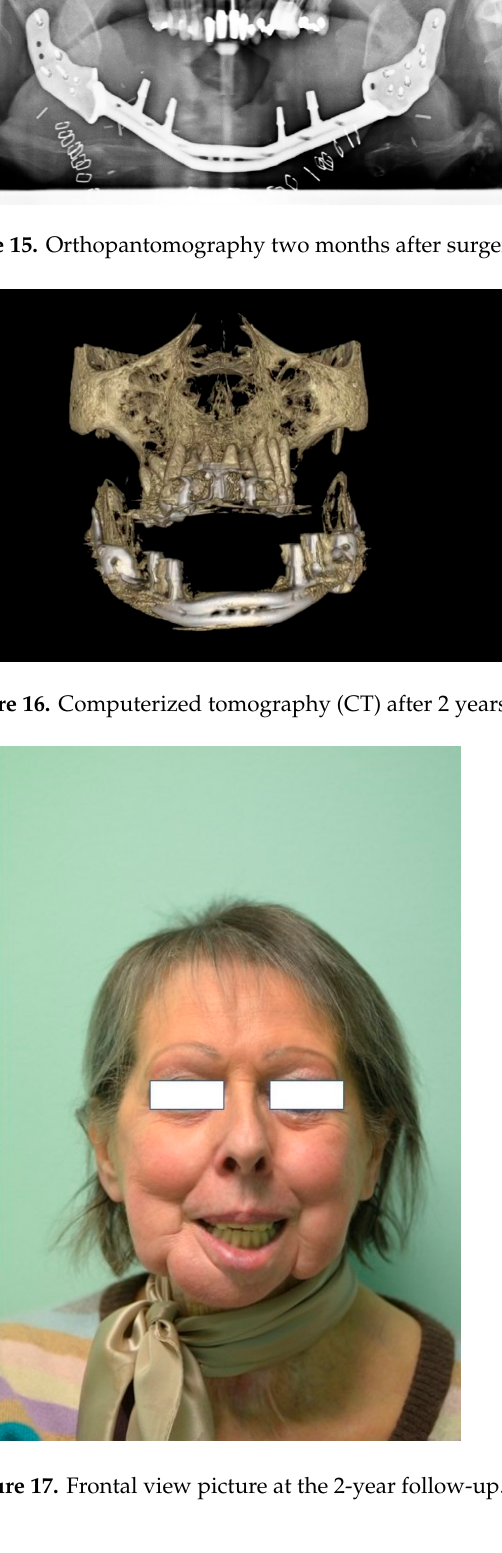
Figure 17. Frontal view picture at the 2-year follow-up.